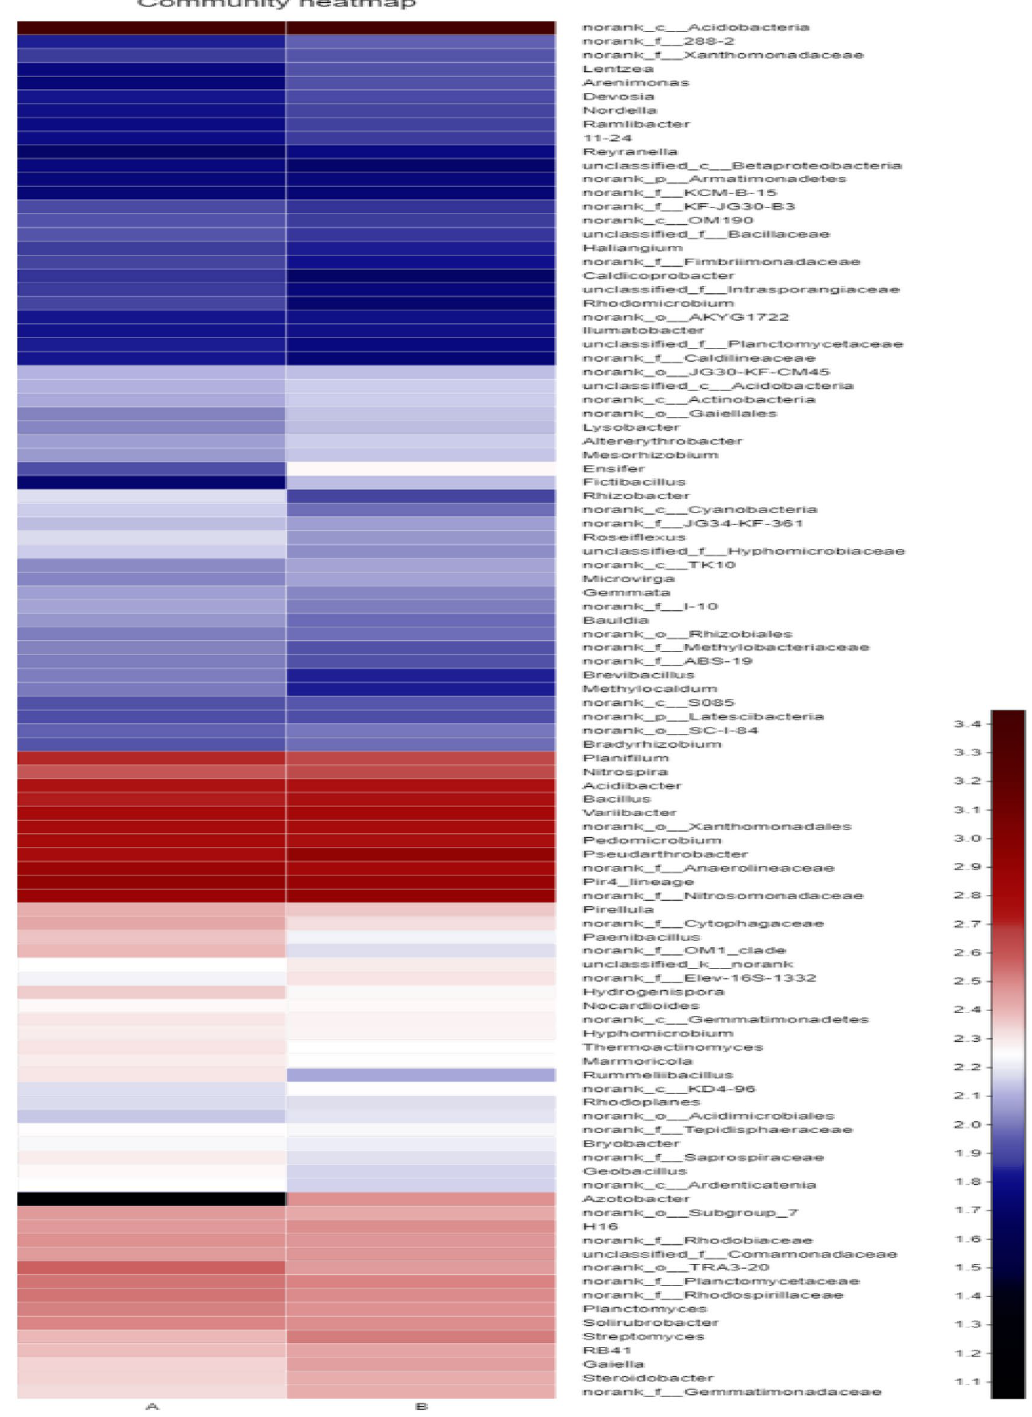
Figure 5. Hierarchical cluster analysis of 100 main OTUs bacterial communities were determined by genus. Scale indicates the relative abundance of each OTU read color intensity. Clustered based on complete linkage method were applied for samples